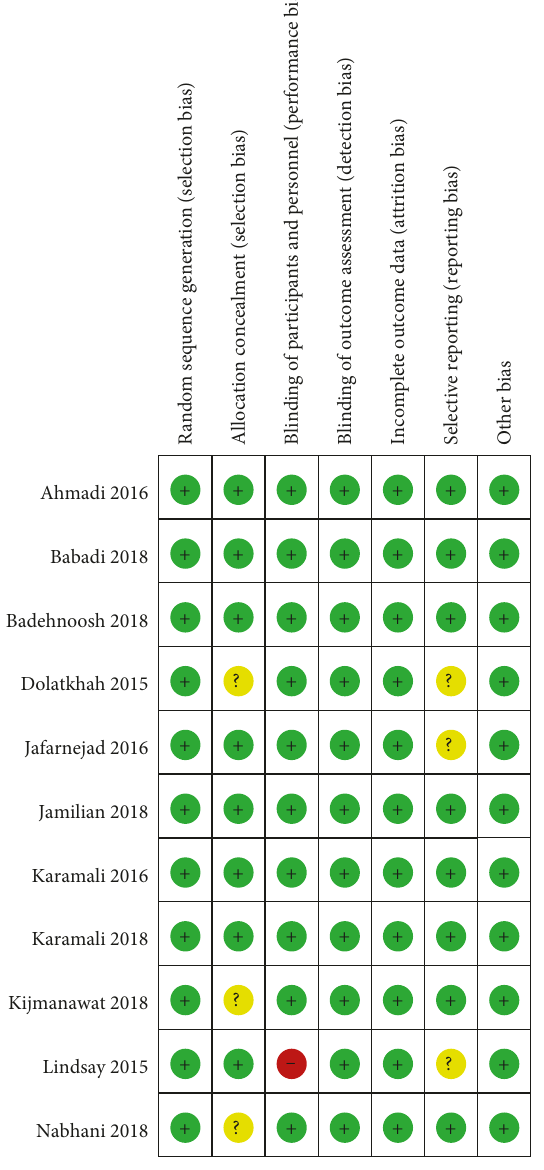
Figure 2: Risk of bias among included randomized controlled